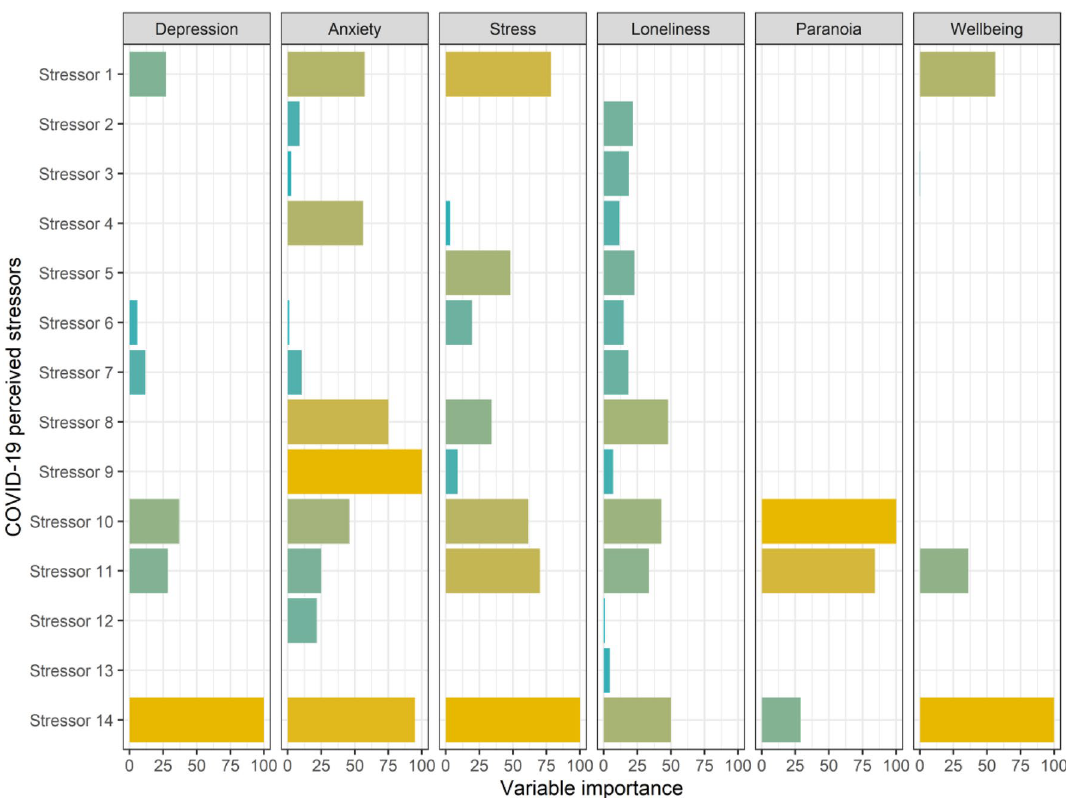
Figure 2. Relative importance of COVID-19 related stressors in predicting psychosocial outcomes. Relative importance was extracted from elastic net regression models with optimal hyperparameters selected during cross-validation (see Supplementary Table S6). Analyses were adjusted for age and sex. Stressor 1 = the current pandemic, Stressor 2 = living in a small accommodation, Stressor 3 = being in quarantine, Stressor 4 = childcare, Stressor 5 = taking over school lessons, Stressor 6 = the curfew, Stressor 7 = being in home office, Stressor 8 = customer service, Stressor 9 = worries about my health, Stressor 10 = worries of not being able to get medical care, Stressor 11 = increased conflicts with people close to me, Stressor 12 = financial worries, Stressor 13 = uncertainties regarding my job, training place, studies or school, Stressor 14 = fears of what the future will bring, or that I won’t be able to cope with